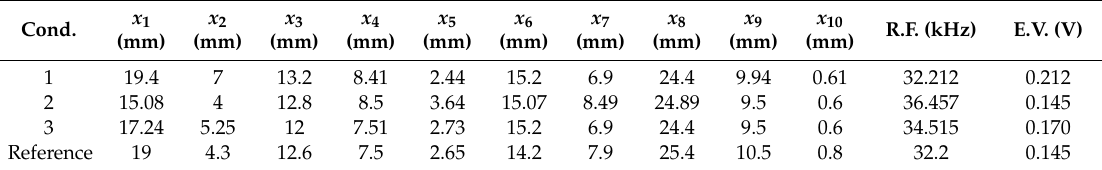
Table 5. Values of optimized design variables for conditions 1, 2 and 3 and corresponding values of resonant frequency and electric voltage.